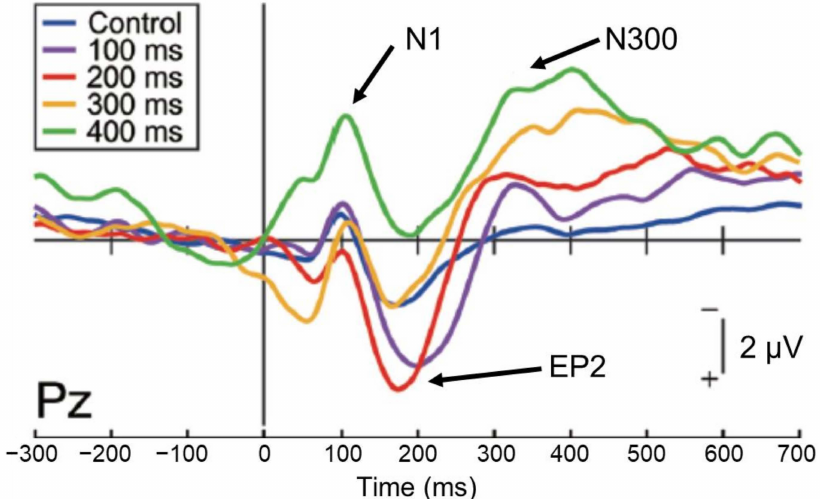
Figure 3. Event-related potential components for self-generated delayed sounds, related to sensory attenuation and the sense of agency [24]. The N1 component is significantly suppressed (sensory attenuation) in the control (no delay) and 100–300 ms delay conditions, but not in the 400 ms delay condition. The N300 component becomes greater as the delay increased, which reflected the attenuation of the sense of